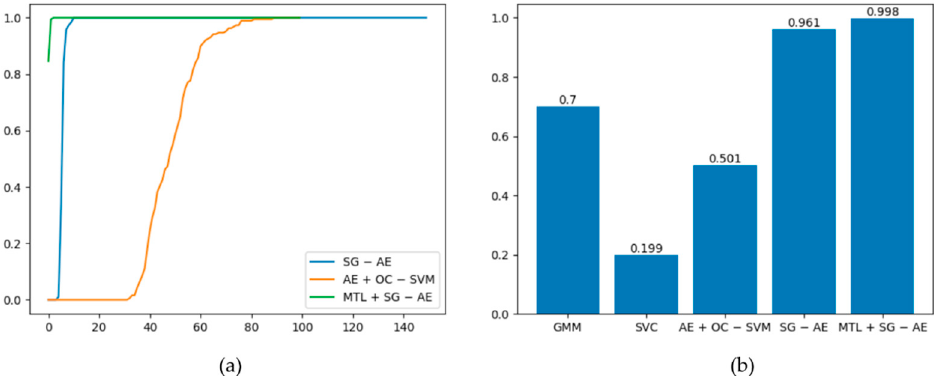
Figure 14. ( a ) Graph of the AUC values of the three depth algorithms changing with the training epochs; ( b ) Average AUC of the five algorithms.